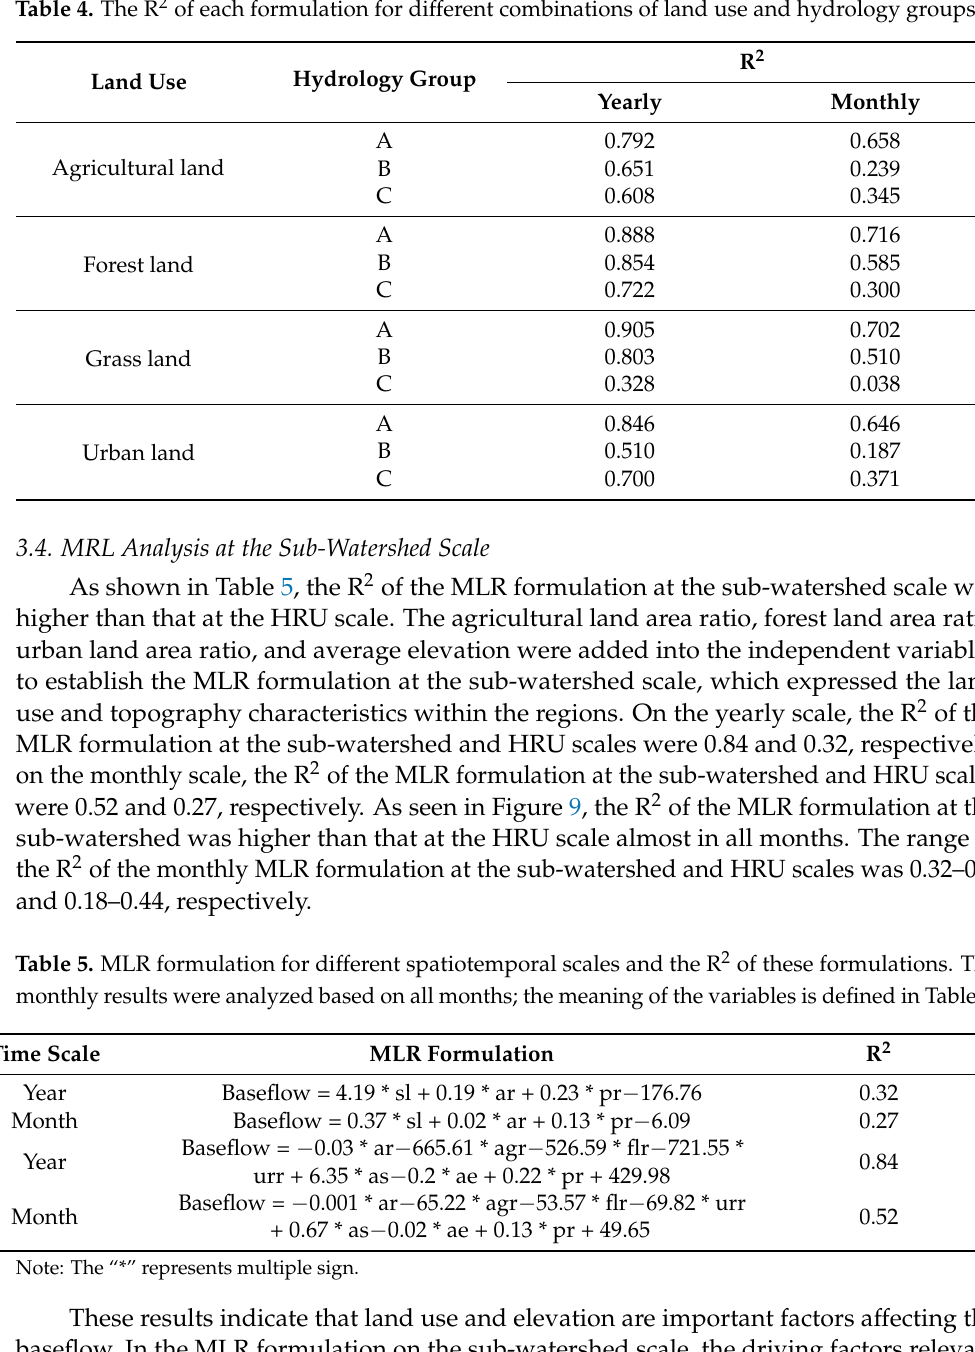
Table 4. The R 2 of each formulation for different combinations of land use and hydrology groups.